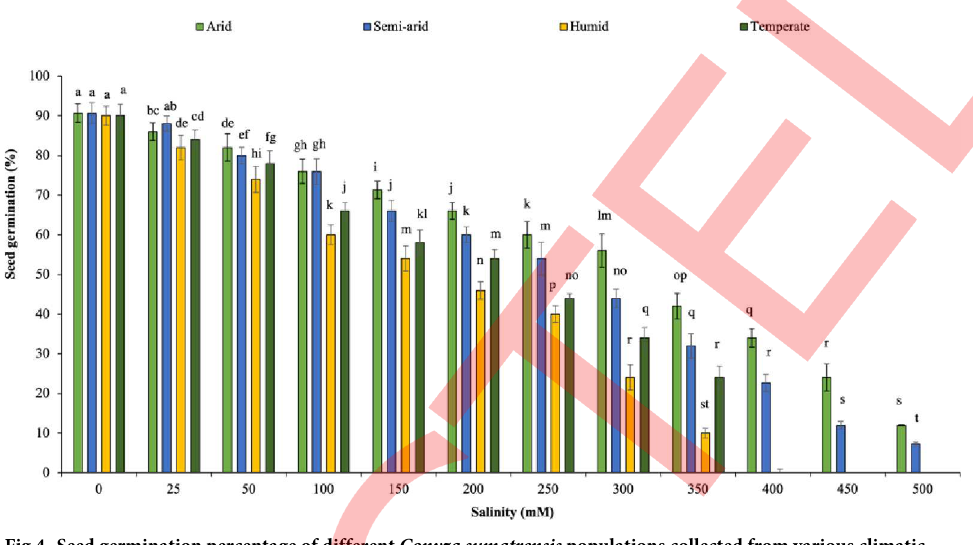
Fig 4. Seed germination percentage of different Conyza sumatrensis populations collected from various climatic regions under different salinity stress levels.